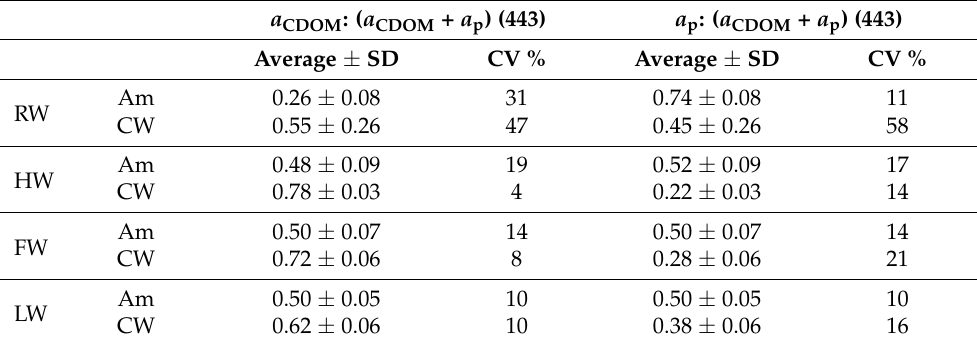
Table 3. Absorption budget of the Amazon River (Am) and clearwater rivers (CW) for rising water (RW), high water (HW), falling water (FW), and low water (LW) seasons.